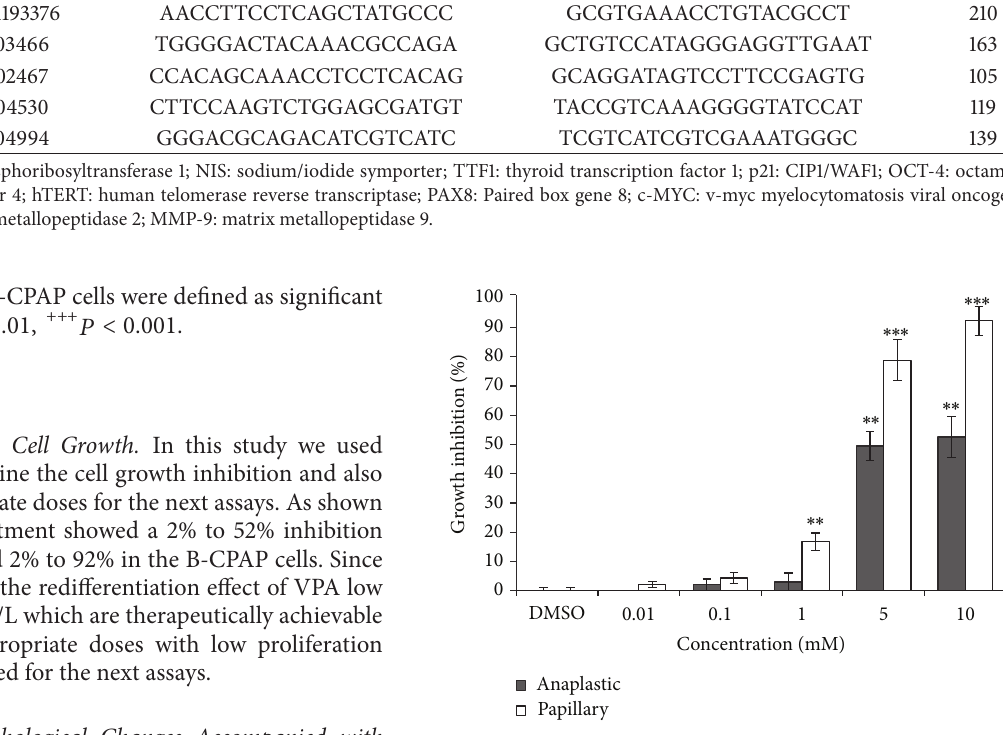
Figure 1: Effects of 0.01, 0.1, 1, 5, and 10mmol/L VPA treatment on 8305C and B-CPAP cell growth inhibition (GI). Proliferation was measuredwithanMTTtestafter96 hofproliferationinthepresence of appropriate amount of DMSO as control or desired VPA. Data are presented as mean of three experiments ± SD. Statistical significance was defined at ∗ 𝑃 < 0.05 , ∗∗ 𝑃 < 0.01 , ∗∗∗ 𝑃 < 0.001 compared to the corresponding